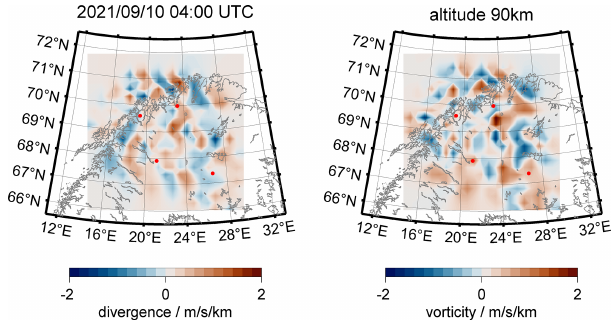
Figure 8. Horizontal divergence and relative vorticity calculated from the 3DVAR+DIV algorithm making use of the horizontal winds. The shown snapshot corresponds to the same period as in Fig.